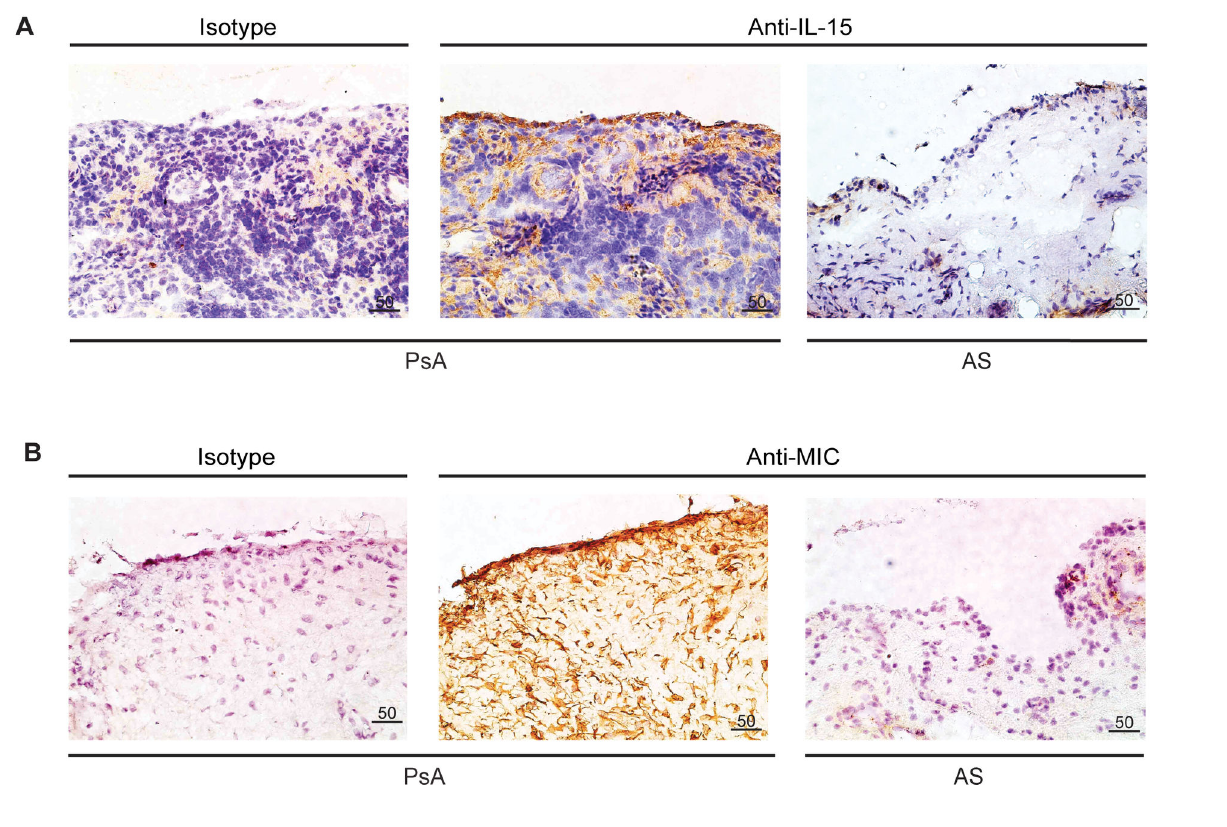
Figure 4. PsA patients have higher levels of IL-15 in their synovial tissue, providing an environment wherein NK cells are primed to the effector stage. ( A ) IL-15 is upregulated in the synovial tissue of patients with PsA but not AS, as shown by immunohistochemical staining using an anti-IL-15 mAb. Staining of a PsA tissue preparation with an isotype control antibody is shown on the left. Images are representative of at least three independent experiments. ( B ) Stress ligand levels are higher in the synovial tissue of PsA patients compared to patients with AS, as shown by immunohistochemical staining using an anti-MIC mAb. An isotype control is shown on the left as in (A). Images are representative of at least three independent experiments. doi: